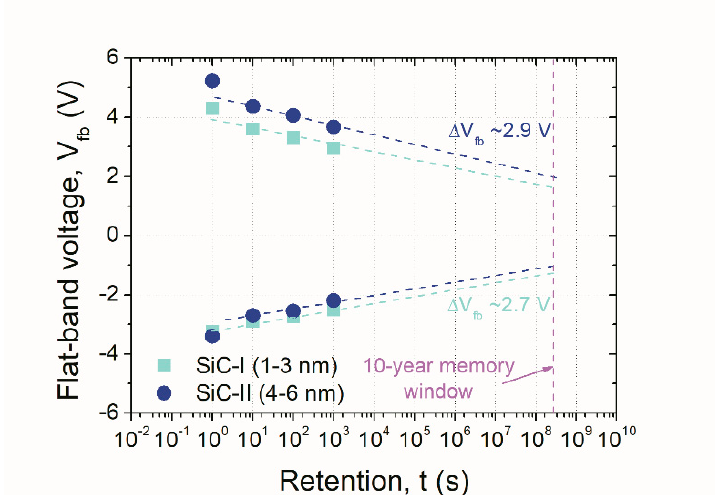
Figure 8. Memory window (expressed as V fb change) of NC-MIS devices with both types of SiC-NCs; V p/e = 0–±12 V, and stress time = 1s were used.